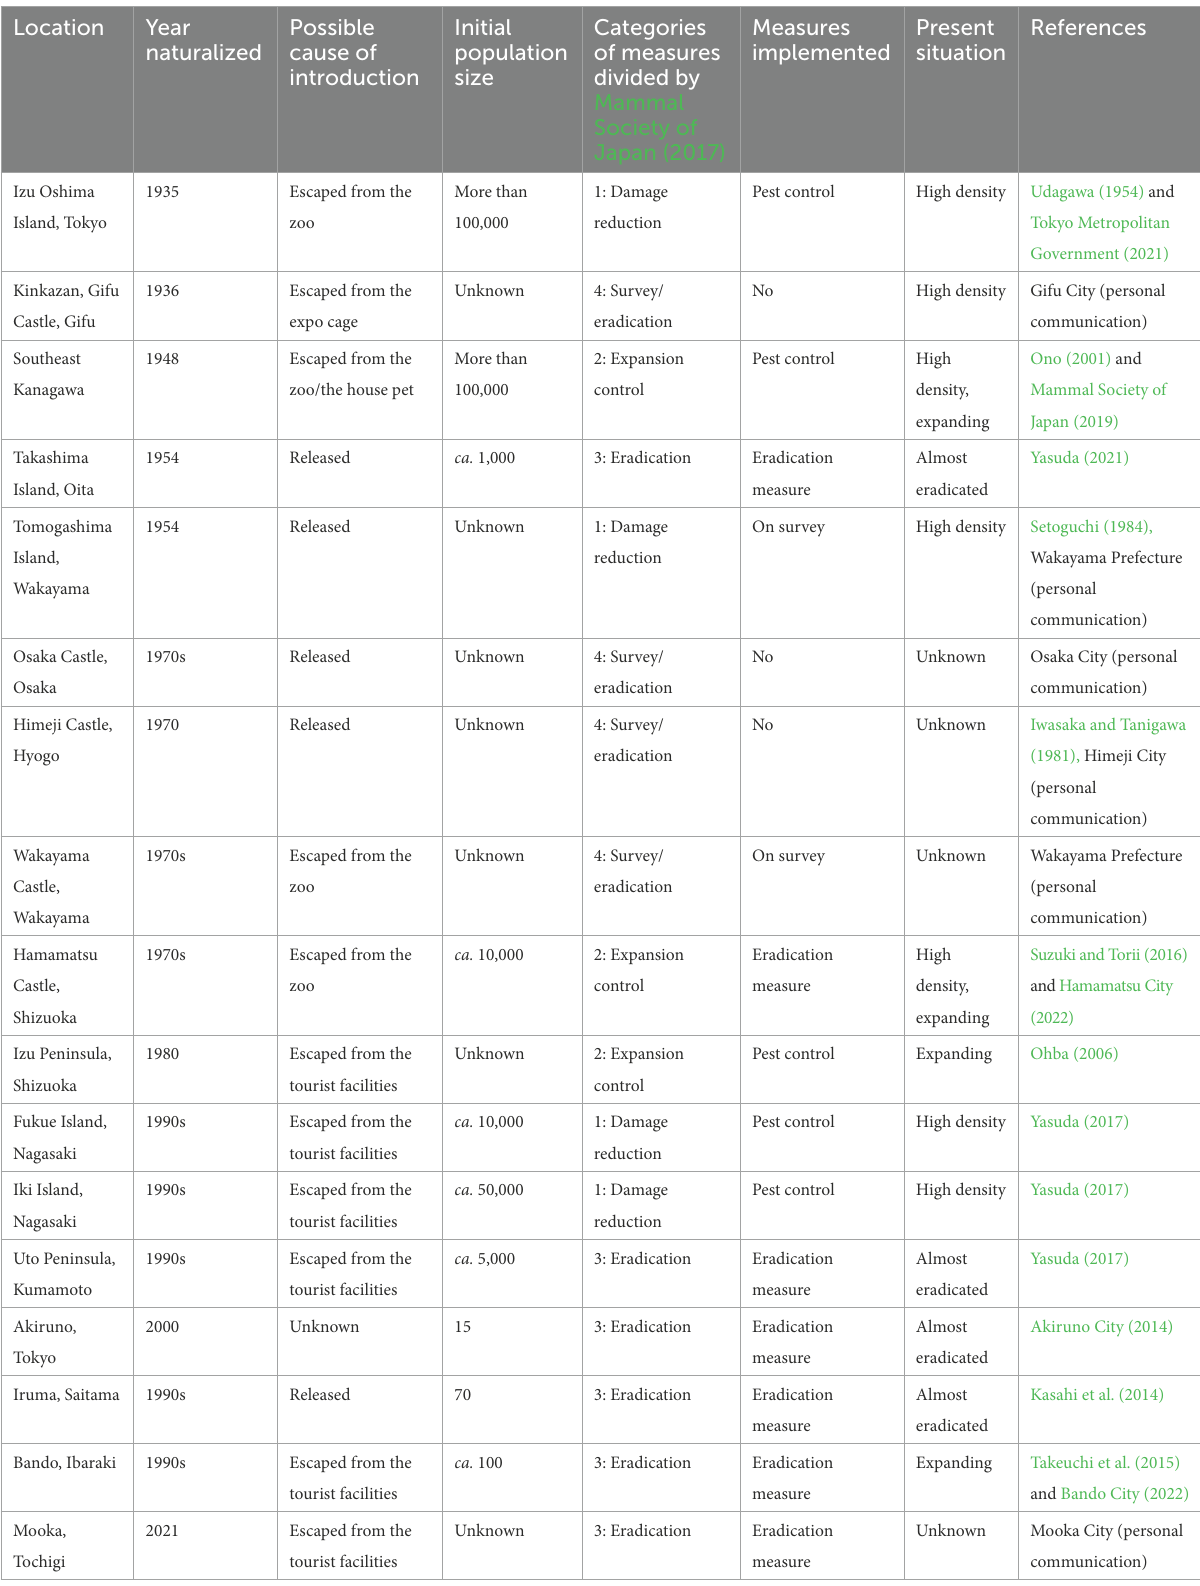
TABLE 1 Locations where Pallas’s squirrels Callosciurus erythraeus have established in Japan and the measures implemented until